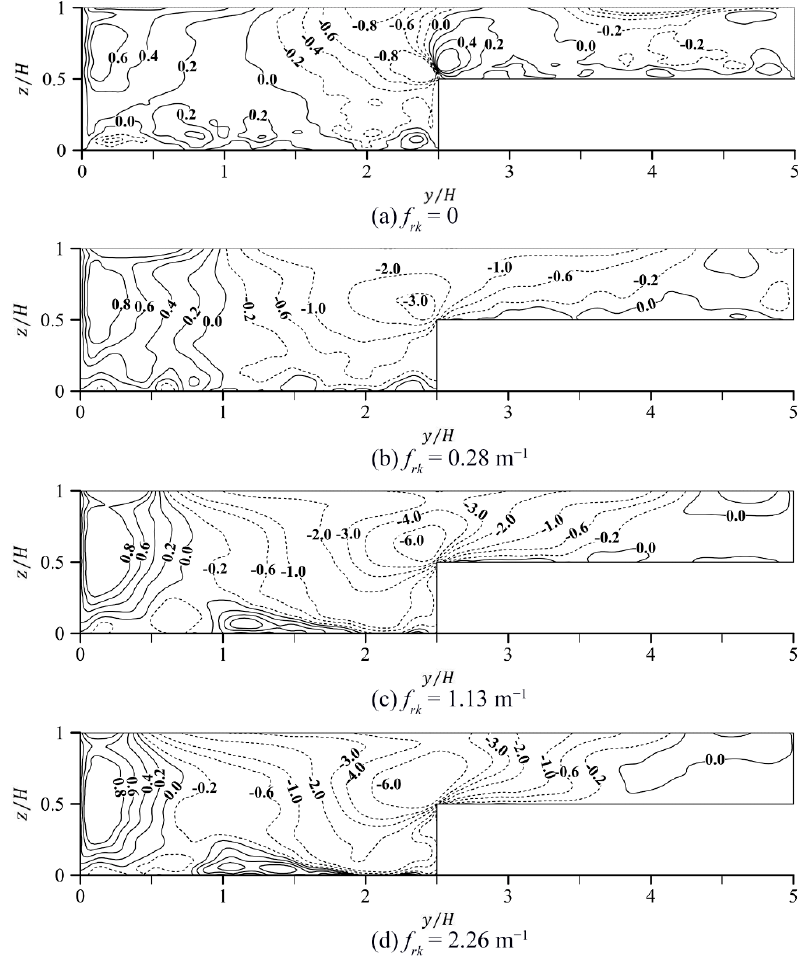
′ ′− 2 uu v Figure 9. Reynolds stress with different floodplain vegetation densities. (a) Case with τ Figure 9. Reynolds stress −(cid:104) u (cid:48) v (cid:48) (cid:105) / u 2 τ with different floodplain vegetation densities. ( a ) Case with f rk =0. (b) Case with f rk =0.28m − 1 . (c) Case with f rk =1.13m − 1 . (d) Case with f rk =2.26m − 1 . f rk = 0. ( b ) Case with f rk = 0.28 m − 1 . ( c ) Case with f rk = 1.13 m − 1 . ( d ) Case with f rk = 2.26 m − 1